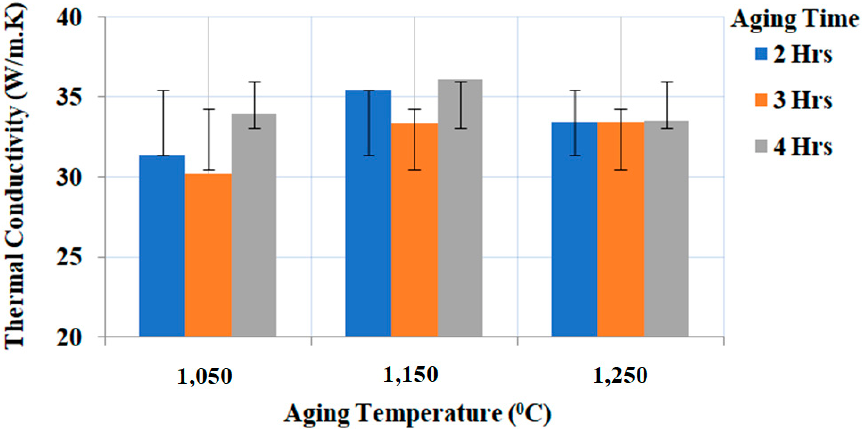
Figure 13. Experimental results plot for thermal conductivity.